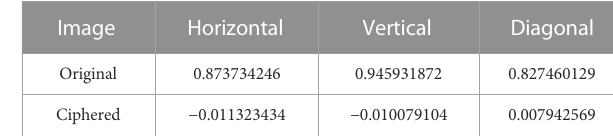
TABLE1Correlationcoef fi cientsindifferentdirectionsoforiginalandciphered images.